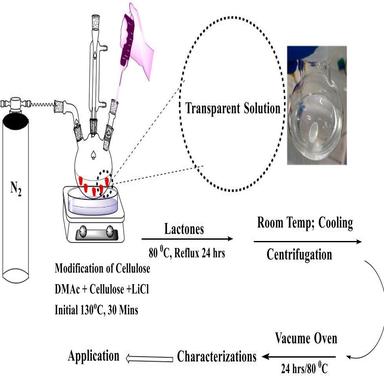
Modification of cellulose.